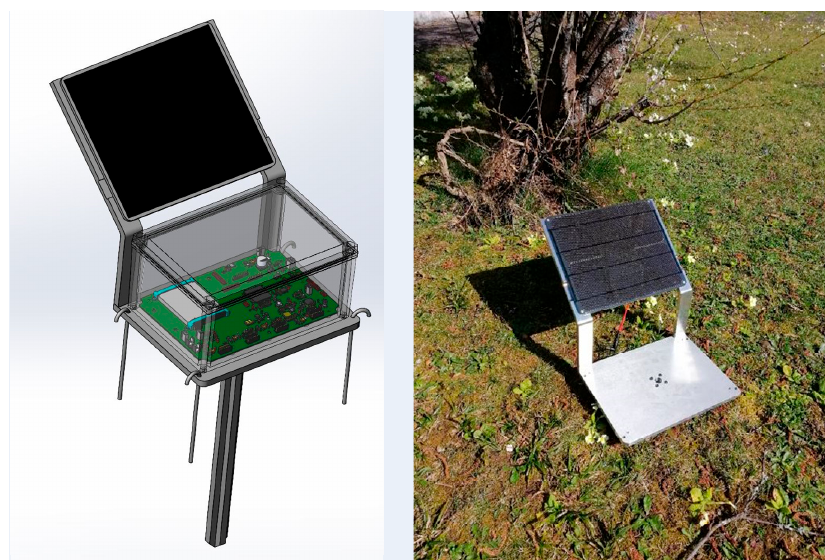
Figure 10 . Smart Data Logger top view with the cover open.